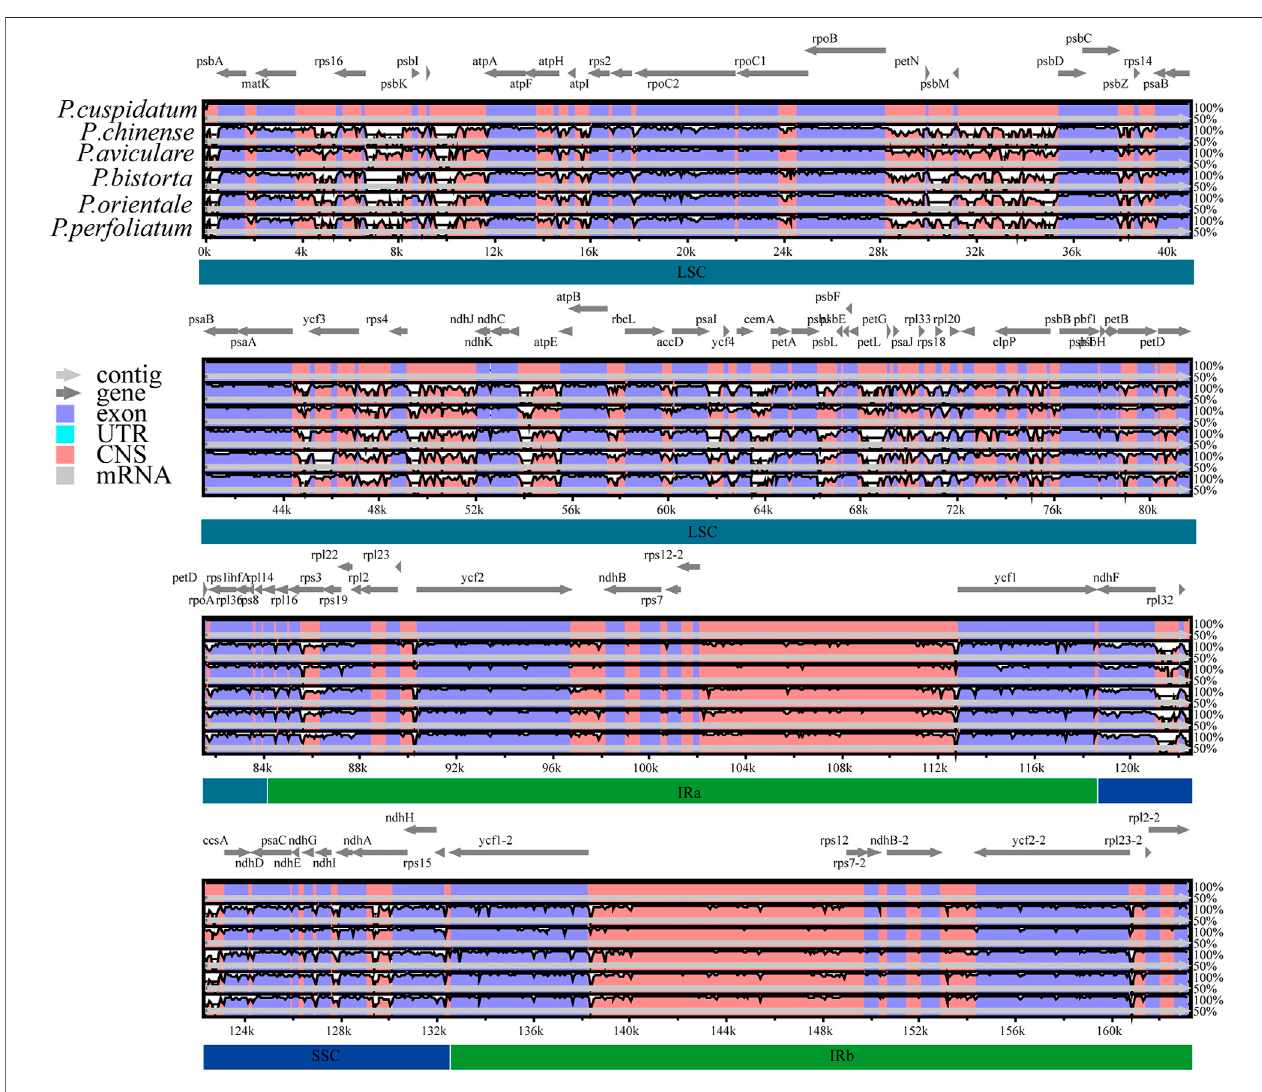
FIGURE4| Comparativeanalysisofchloroplastgenomedifferencesinsix Polygonum cpgenomes.Grayarrowsandthickblacklinesabovethealignmentindicate gene orientation. Purple bars represent exons, blue bars represent untranslated regions (UTRs), pink bars represent non-coding sequences (CNS), and gray bars represent mRNA. The y-axis represents the percentage identity (shown: 50 –